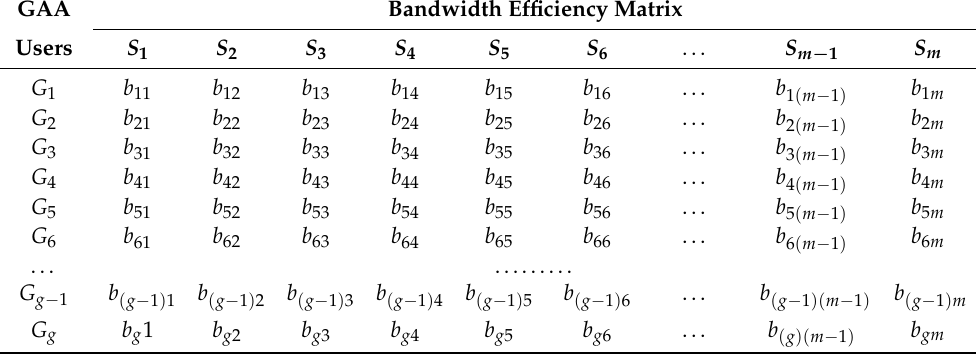
Table 3. Bandwidth efficiency matrix.